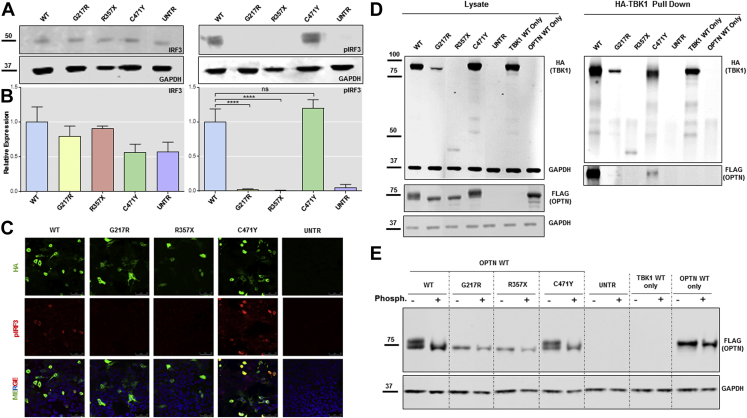
TBK1 p.G217R and p.R357X impair IRF3 phosphorylation as well as TBK1 binding with OPTN and its phosphorylation. (A) Western blot analysis of IRF3 (left) and pIRF3 (right). (B left) Quantitative analysis of blot in (A) left showing a similar expression level of endogenous IRF3 in cells (n = 3). (B right) Quantitative analysis of blot in (A) right showing a significant decrease of expression of endogenous pIRF3 in cells transfected with TBK1-p.G217R and p.R357X (n = 3, analyzed by one-way ANOVA followed by Dunnett's post test p < 0.0001). (C) Qualitative immunocytochemistry of HEK293T transfected with TBK1-WT, p.G217R, p.R357X, and probed for p-IRF3 confirming the result obtained by Western blot analysis (scale bar = 50 μm). (D) Co-IP with HA-tag pull down (TBK1) showing no binding of OPTN in any of the mutated samples with the exception of p.C471Y (n = 3). (E) HEK293T were transiently cotransfected with Flag-OPTN WT and HA-TBK1 WT, p.G217R, p.R357X, or p.C471Y, treated with alkaline phosphatase and analyzed by Western blot showing lack of OPTN phosphorylation in all mutated samples a part from p.C471Y. Abbreviations: IRF3, interferon regulatory factor 3; OPTN, optineurin; TBK1, TANK binding kinase 1; WT, wild type. **** p ≤ 0.0001.